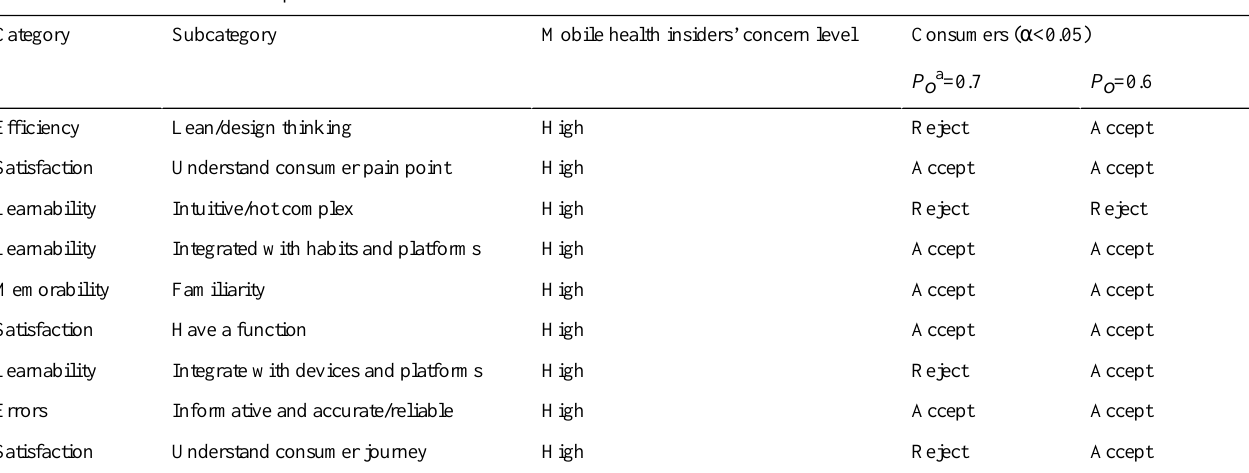
Table 2. Mobile health insiders’top concerns versus consumer’s